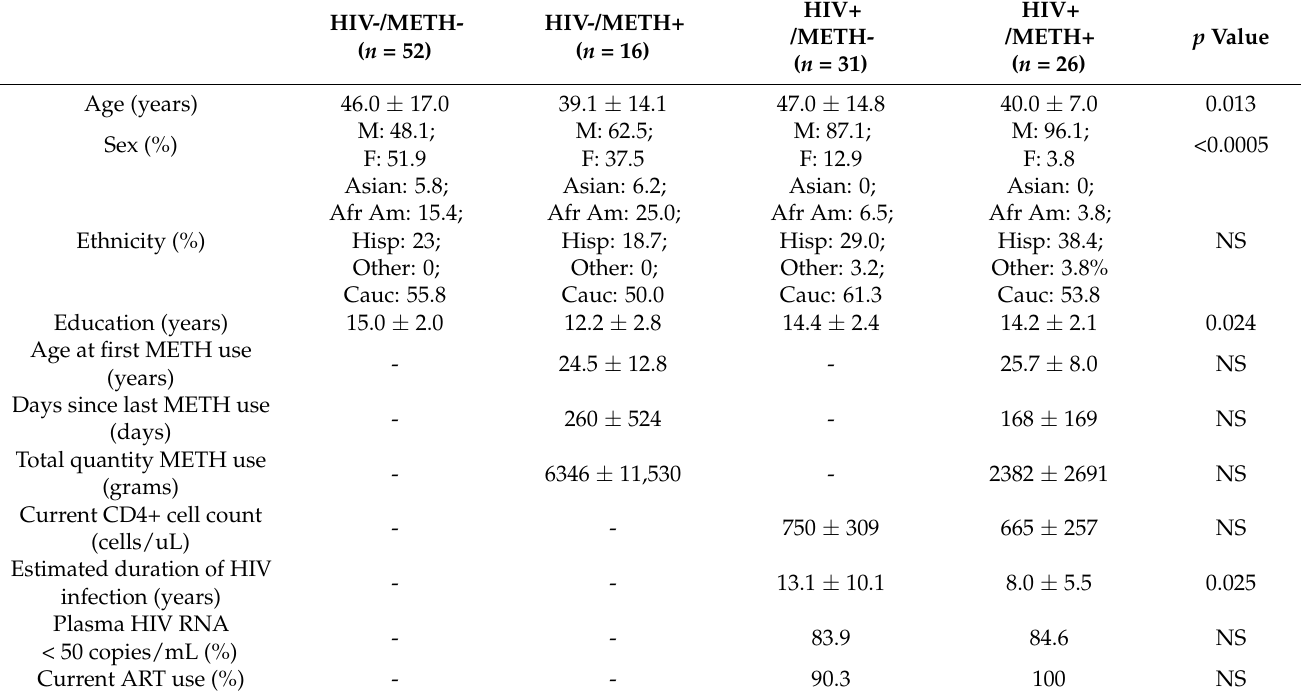
Table 1. Demographic information for participants with plasma